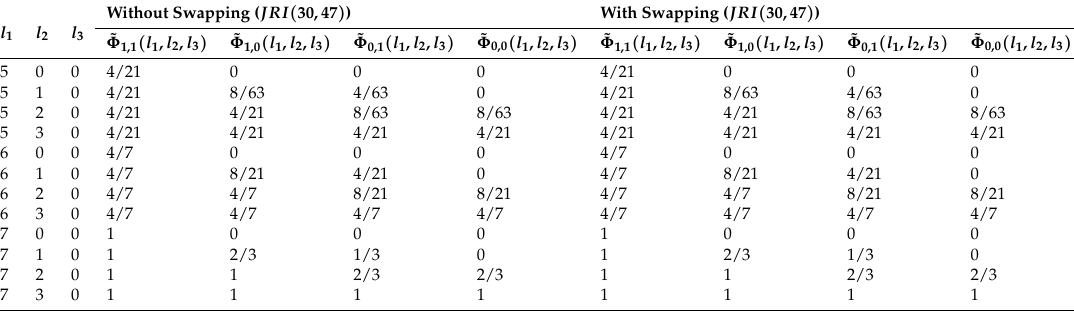
Table A6. Survival signatures of given states of components 30 and 47 (rows with ˜ Φ i , j = 0 are omitted). Without Swapping ( JRI ( 30,47 )